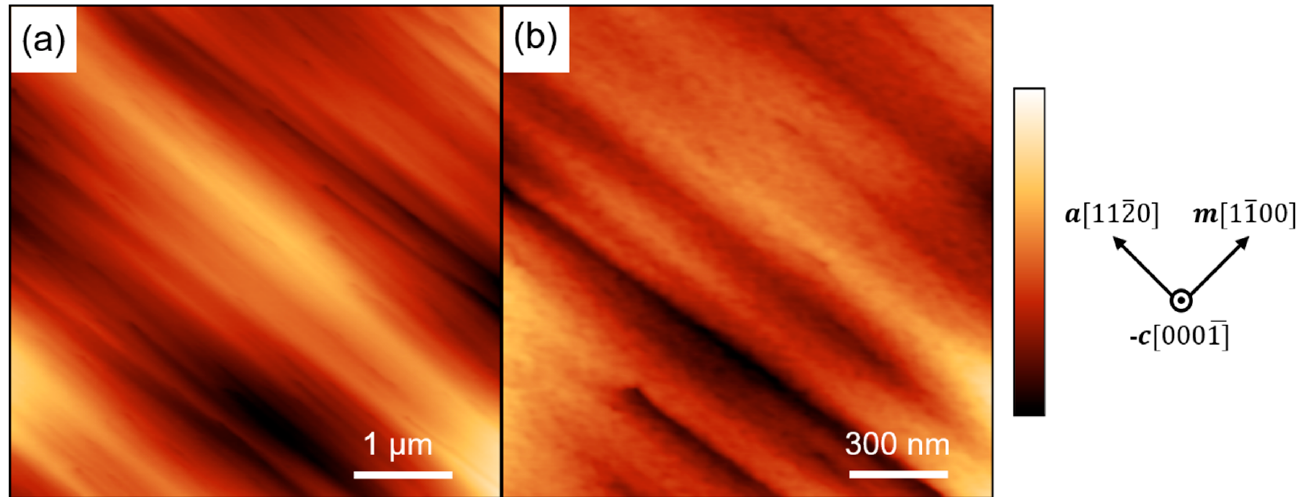
Figure 2. AFM images of N − polar semi − insulating GaN template with surface steps parallel to the GaN a − direction. ( a ) 5 × 5 µm. ( b ) 1.5 × 1.5 µm. Scale bar shown at right is 0–50 nm for ( a ) and 0–15 nm for ( b ).